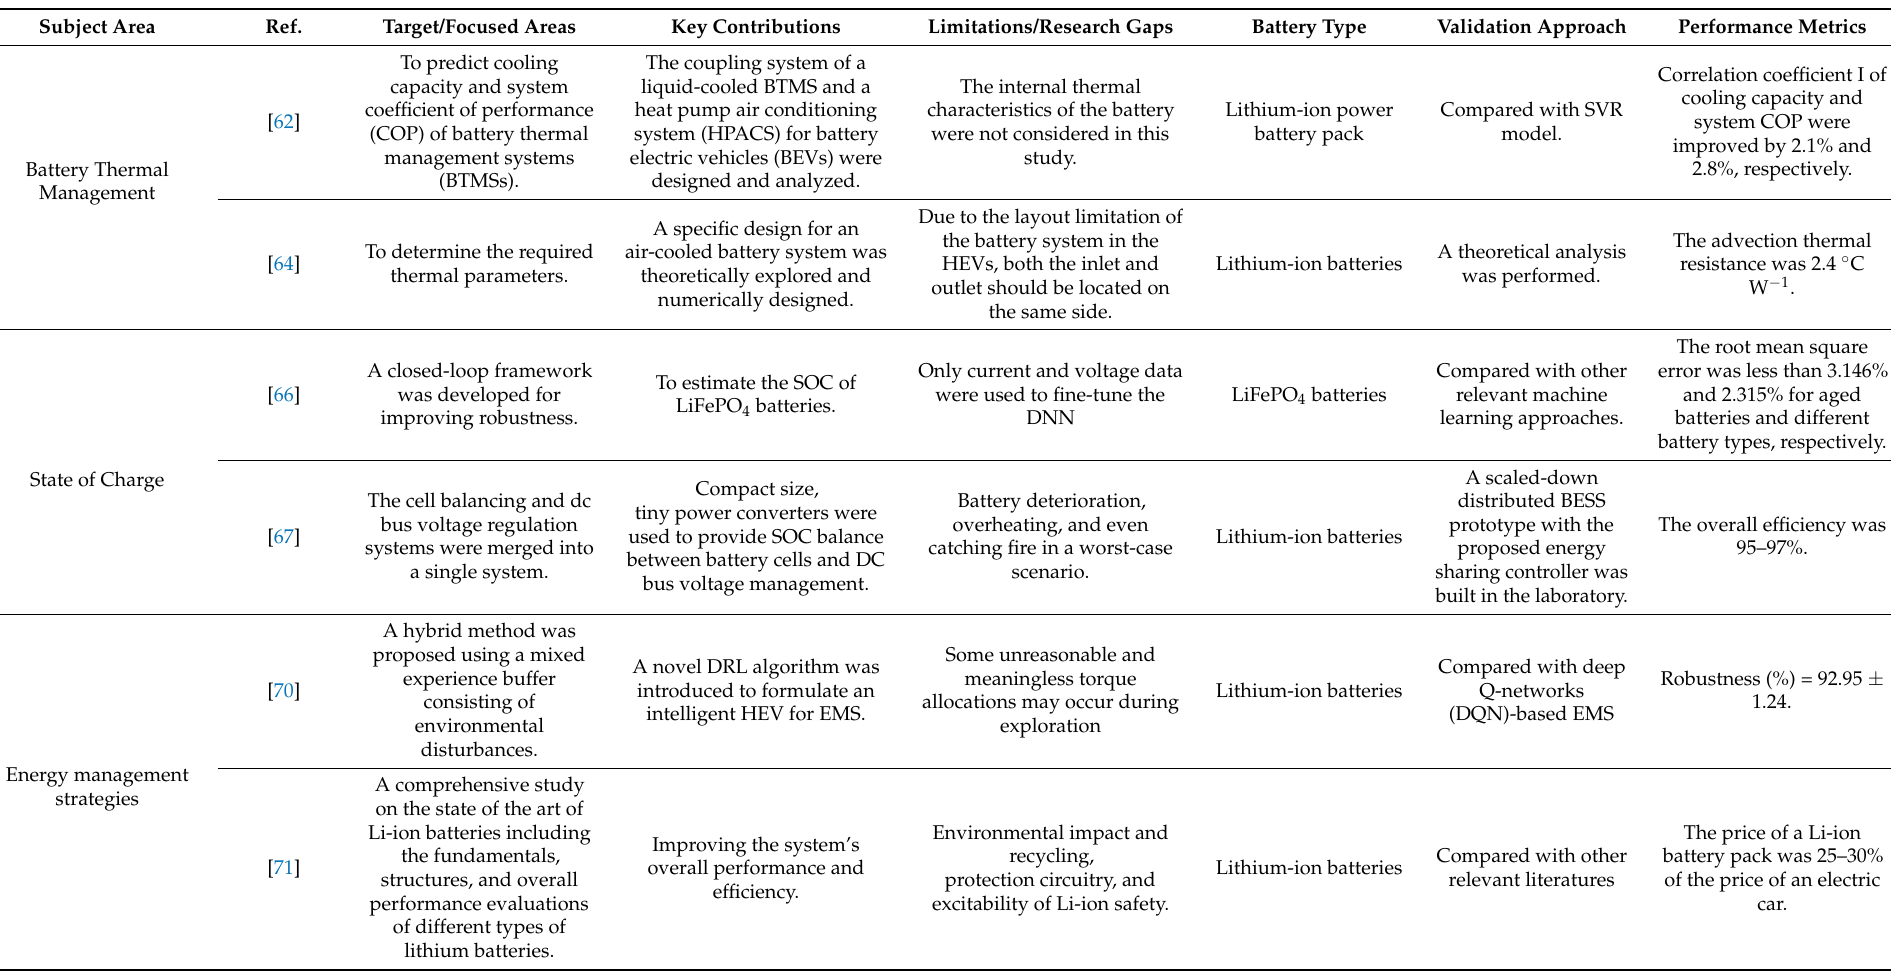
Table 4. Comparative analysis of BMS components and functions in EV